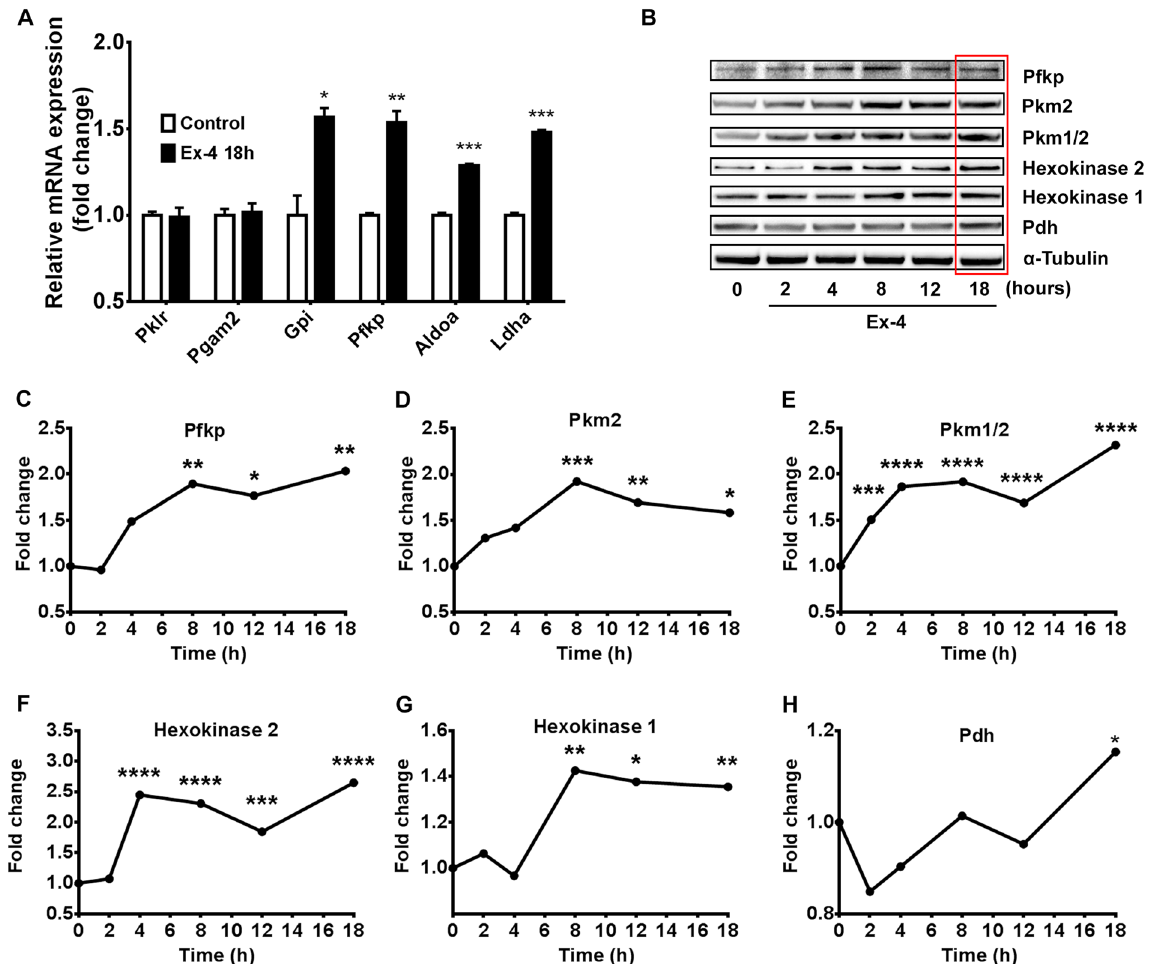
Figure 3. 18 h of GLP-1R stimulation induces mRNA and protein expression of glycolytic enzymes. ( A ) mRNA expression of the glycolytic enzymes Pyruvate Kinase (Pklr), Lactate dehydrogenase A (Ldha), Aldolase A (Aldoa), Phosphofructokinase (Pfkp), Glucose-6-phosphate isomerase (Gpi) and Phosphoglycerate mutase 2 (Pgam2) was assessed by qRT-PCR in BRIN-BD11 cells exposed (or not) to 50 nM Exendin-4 for 18 hours. ( B ) Protein levels of glycolytic enzymes were analysed by immunoblot following 0, 2, 4, 8, 12 and 18 hours of exposure to 50 nM Exendin-4. Expression levels of ( C ) Pfkp, ( D and E ) Pyruvate Kinase M1 and M2 (Pkm1, Pkm2), ( F ) Hexokinase 1, ( G ) Hexokinase 2 and ( H ) Pyruvate dehydrogenase α 1 subunit (Pdh) were quantified by band densitometry analysis. Data represent mean ± SEM, n ≥ 3; * P < 0.05; ** P < 0.01; *** P < 0.001; **** P <